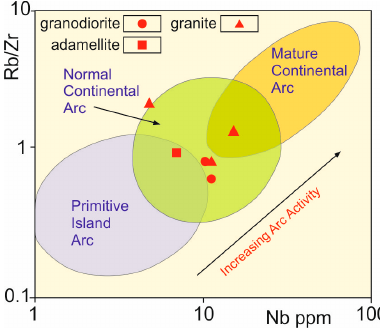
Figure 11. Discrimination Rb/Zr–Nb diagram for Ergelyakh massif granitoids [57].